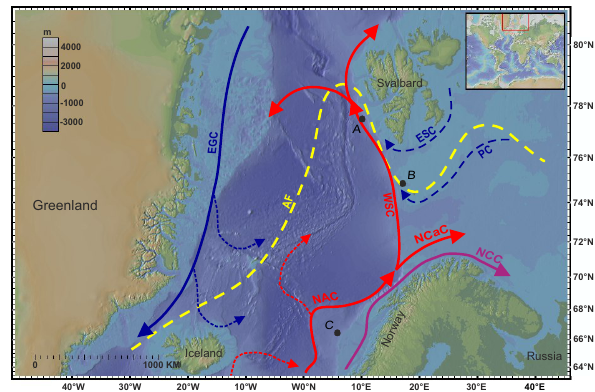
Fig. 1. Bathymetric map of the Nordic Seas showing the major oceanic features and site locations. Red arrows: flow direction of warm saline Atlantic water (NAC: North Atlantic Current, NCaC: North Cape Current, WSC: West Spitsbergen Current), blue arrows: flow direction of cold low salinity Arctic/Polar waters (EGC: East Greenland Current, ESC: East Spitsbergen Current, PC: Persey Cur- rent), purple arrow: flow direction of coastal surface current (NCC: Norwegian Coastal Current). Dashed yellow line: modern distribu- tion of the Arctic front (AF). Core locations A: HH11-134-BC (west of Spitsbergen), B: JM09-KA11-GC (western Barents Sea) and C: MD95-2011 (Vøring